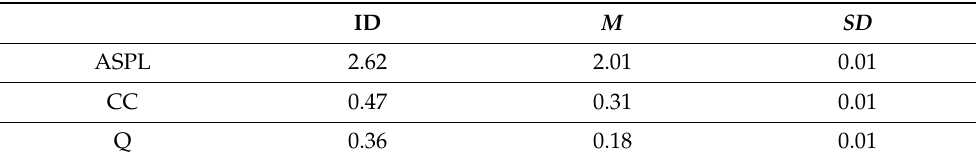
Table A5. Random Network comparison for the network of the adolescents with ID (dataset 4), p < 0.001 for all comparisons.